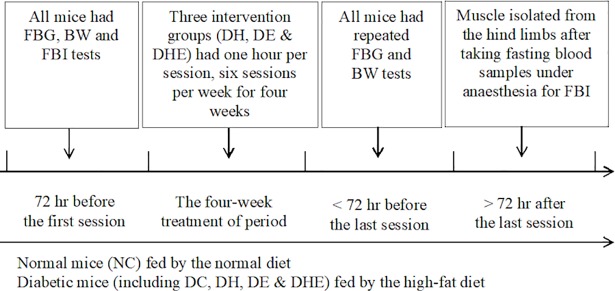
The study design.